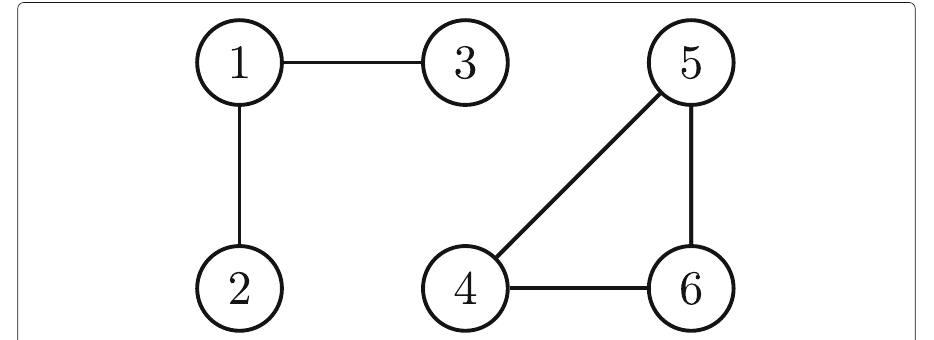
Fig. 3 Inverse graph of dihedral group D